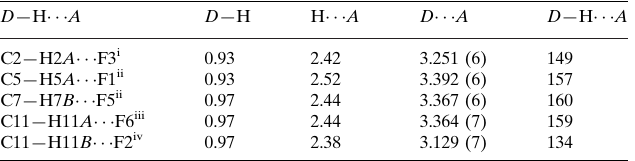
Hydrogen-bond geometry (A˚ , (cid:3)